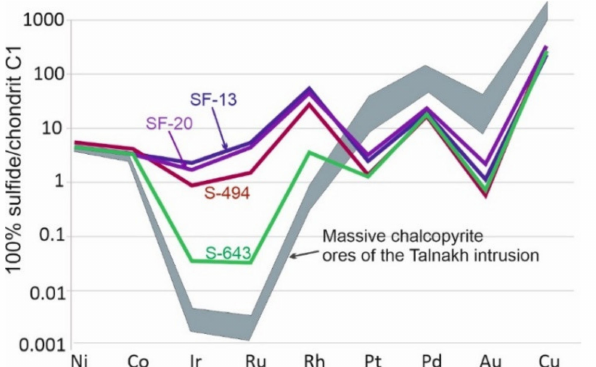
Figure 10. PGE Content (ppm) in the ores of the studied boreholes from the Skalisty mine, Talnakh intrusion.